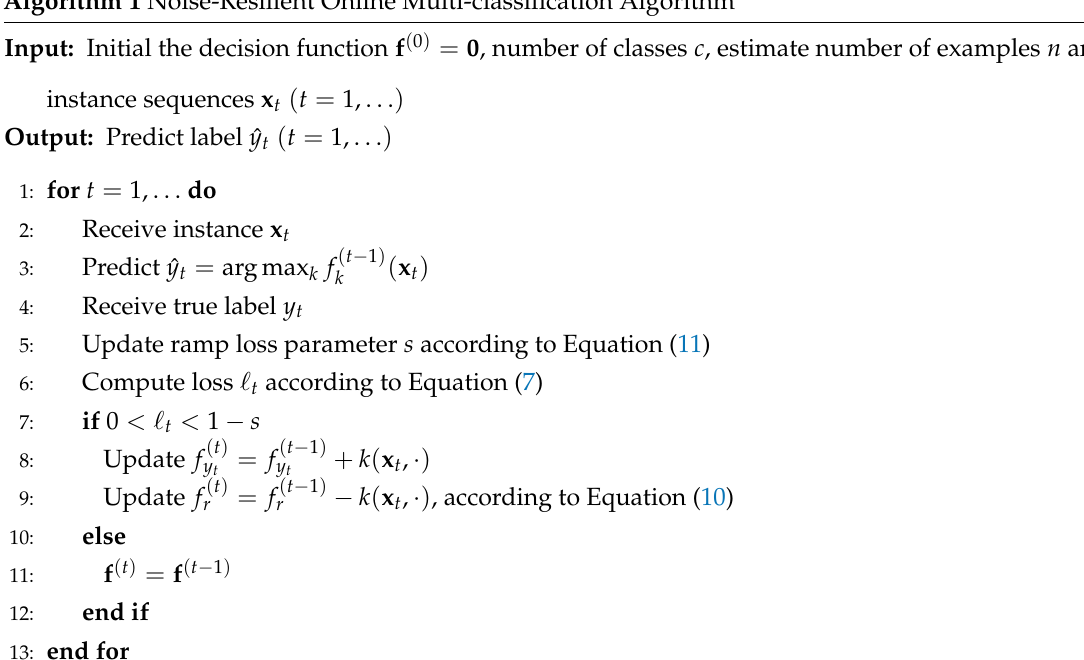
Algorithm 1 Noise-Resilient Online Multi-classification